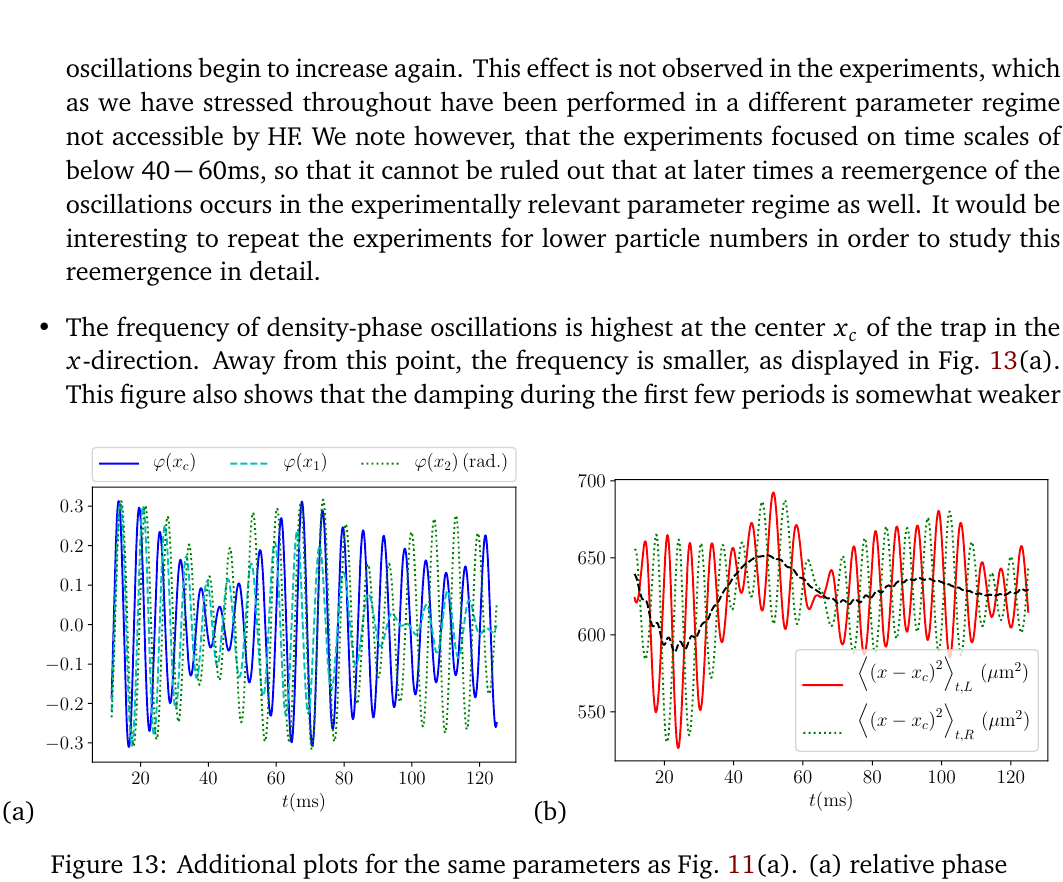
= x + 25 µ m, x = x + 37.5 µ m. (b) c c 1 2